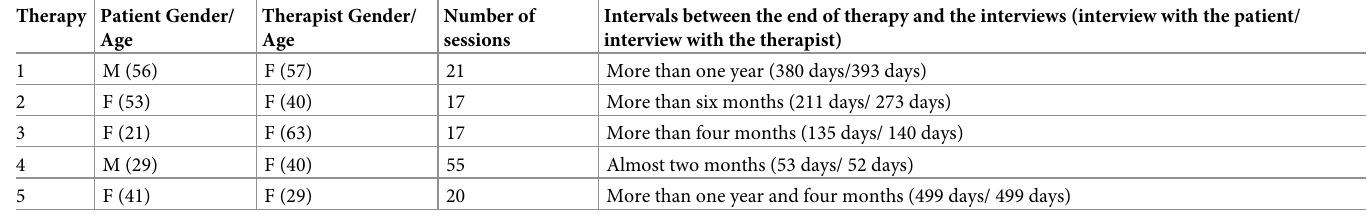
Table 1. Characteristics of the sample arranged by couple.